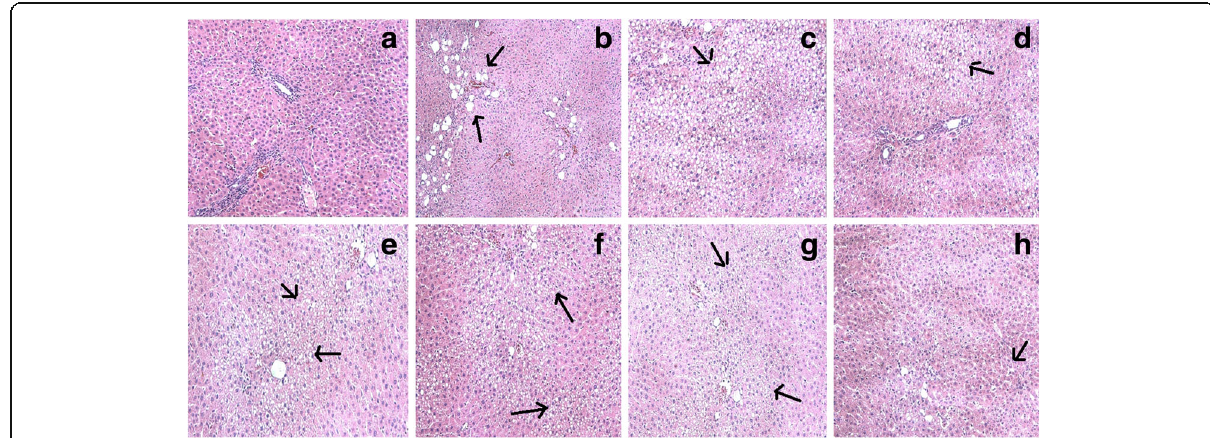
Fig. 3 Liver histological structure of rats in normal control ( a ), toxic control ( b ), plain silymarin tablet ( c ), marketed formulation ( d ), Silymarin – Lysergol ( e ), Silymarin – Piperine ( f ), Silymarin – Fulvic acid ( g ) and Silymarin – Fulvic acid- Piperine ( h ) (H+E×100). The small arrows are used to show the extent of necrosis and presence of